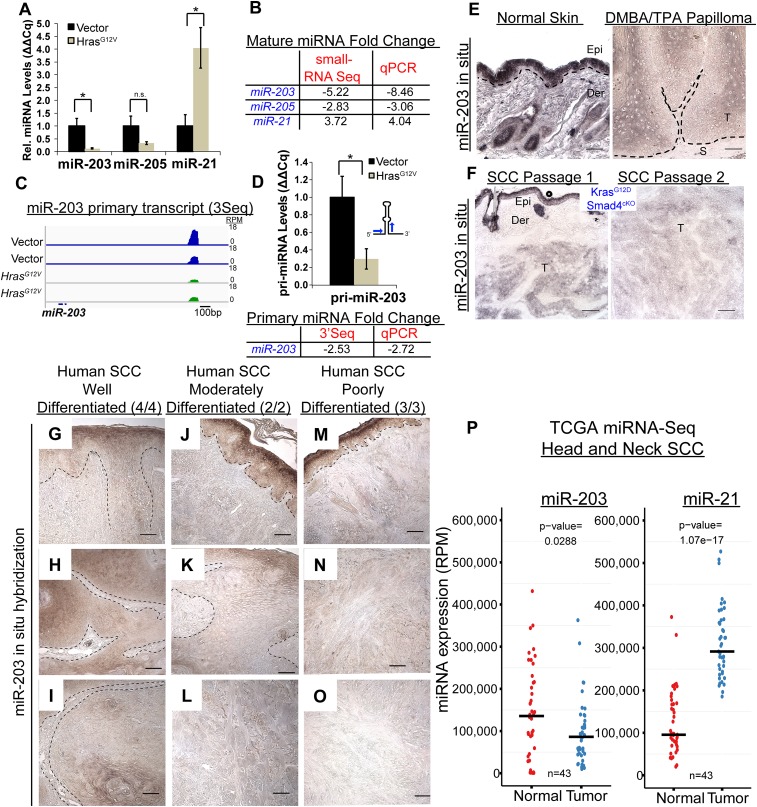
miR-203 is strongly suppressed in mouse and human SCCs.(A, B) qPCR and small-RNA-Seq independently validate downregulation of miR-203 and upregulation of miR-21 driven by oncogenic HrasG12V (n = 3 biological rep. qPCR, n = 2 small-RNA-Seq, mean ± SEM displayed, *p < 0.05, Student's t-test two-sided). (C) Gene track and quantification the 3′end of the miR-203 primary transcript based on 3Seq. (D) miR-203 primary transcript detection by qPCR (n = 3 biological replicates, Mean ± SEM displayed, *p < 0.05, ns = non-significant, Student's t-test two-sided). (E) miR-203 is downregulated in DMBA/TPA produced papillomas compared to normal adjacent tissue. Epi = epidermis, Der = dermis, T = tumor, and S = stroma. The black lines denote the epidermal/dermal and tumor/stroma boundary (F) miR-203 is downregulated in malignant SCCs derived from KrasG12D/Smad4cKO and passaged in immunocompromised mice. (G–O) Reduced miR-203 expression is correlated with increasing malignancy in human skin SCC cancers. Panels G, J, M were taken from regions with more histologically normal regions to demonstrate successful miR-203 hybridization. (P) miRNA-Seq quantification from patient matched normal and tumor tissue obtained from the TCGA consortium data (bar indicates mean value, Student's t-test two-sided). Scale bar = 50 μm.